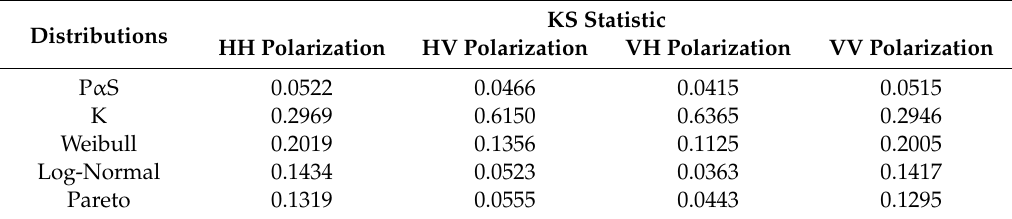
Table A1. The fitting results for sea clutter in the IPIX